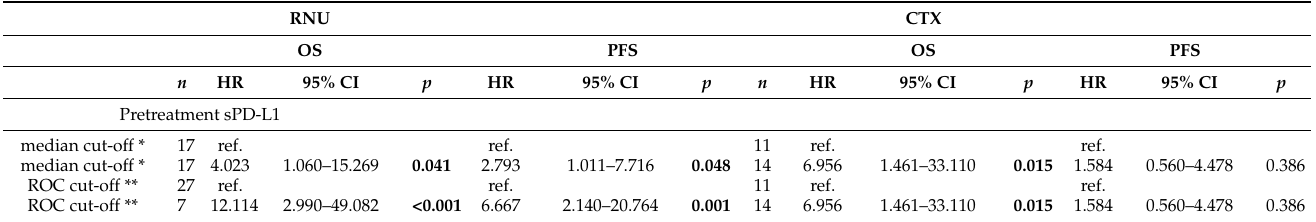
Table 3. Correlation of pretreatment sPD-L1 concentrations with patients’ prognosis *—median cut-off value for RNU is 84.0 pg/mL, median cut-off value for CTX is 96.1 pg/mL; **—ROC cut-off value for RNU is 118.5 pg/mL, ROC cut-off value for CTX is 93.9 pg/mL; RNU—radical nephroureterectomy, CTX—chemotherapy; OS—overall survival; PFS—progression-free survival, bold font significant value.